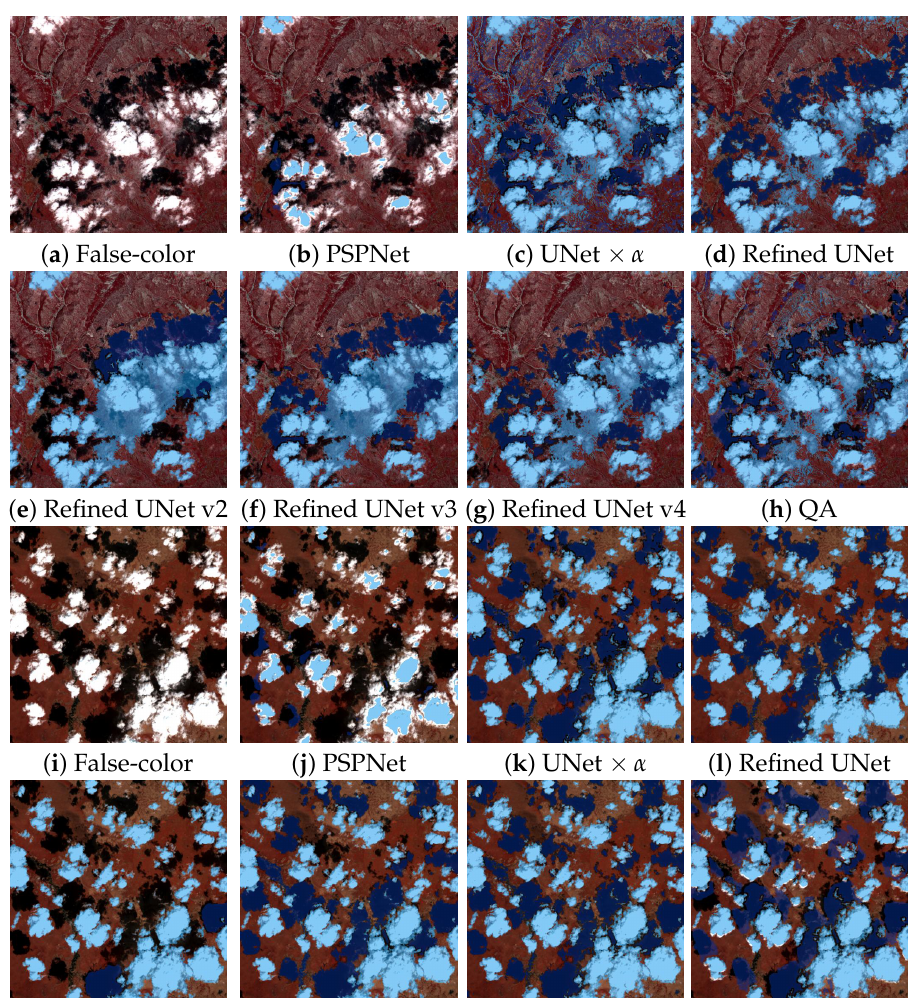
Figure 6. Typical visual examples of local patches